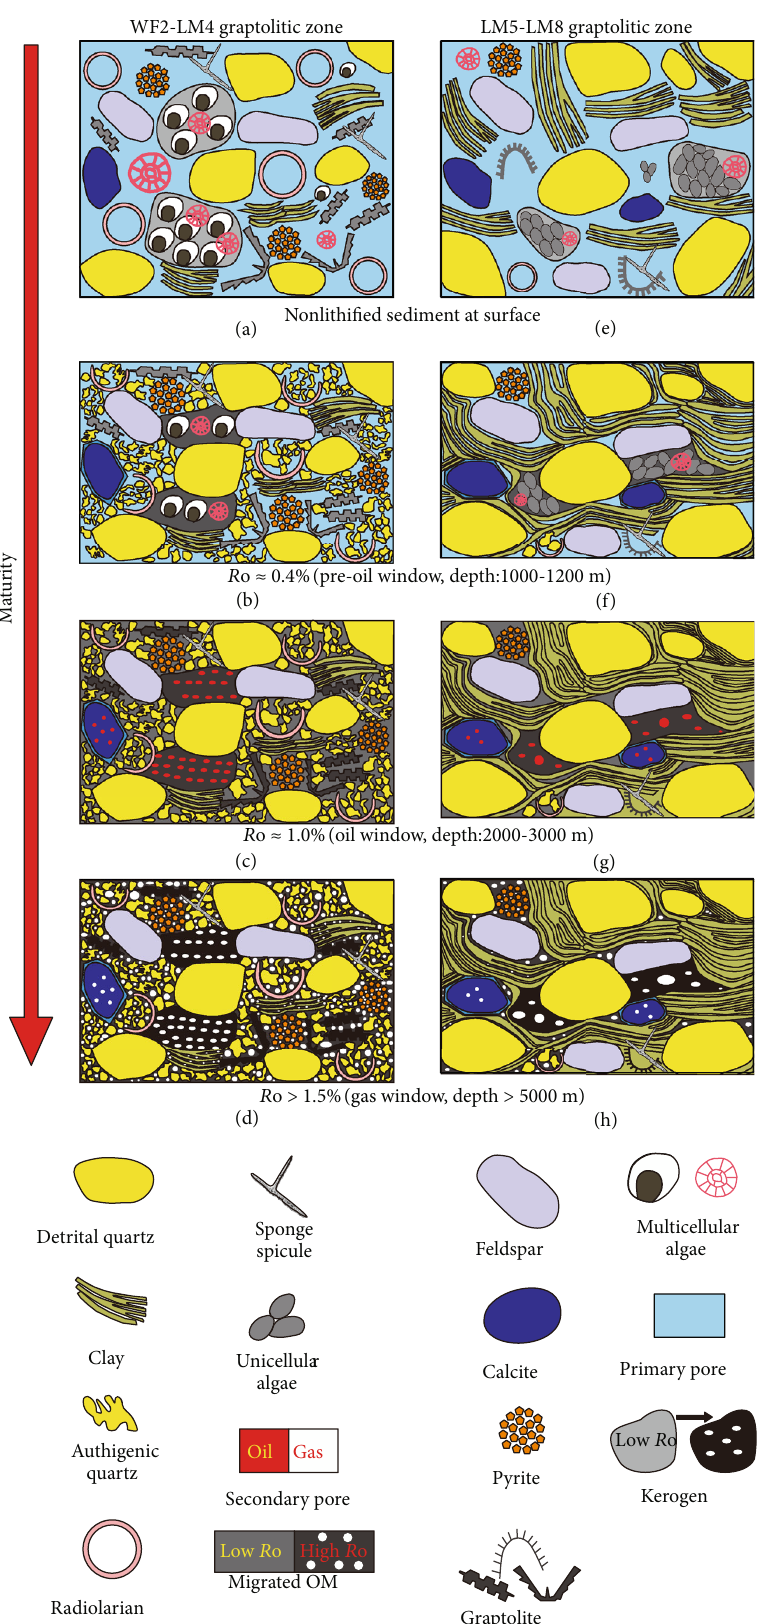
Figure 10: The coevolution processes of the reservoir (WF2-LM4 GZ) and the seal (LM5-LM8